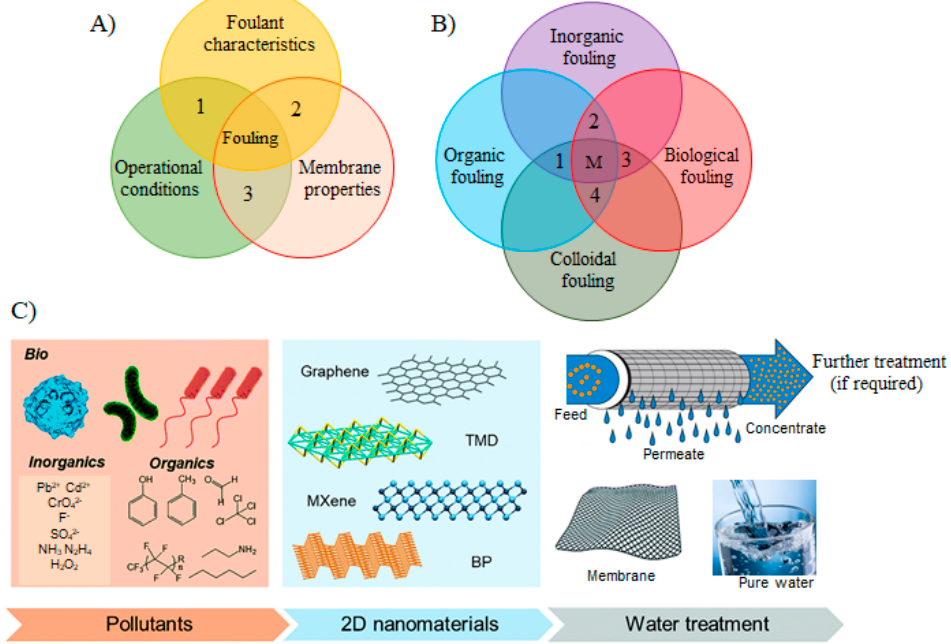
Figure 2. ( A ) Factors affecting the membrane fouling: (1) foulant characteristics such as concentration, size, solubility, diffusivity, hydrophobicity, charge, etc.; (2) membrane properties such as hydrophobicity, surface roughness, pore size, charge on membranes surface, and surface functional groups; (3) operational conditions such as flux, medium tempera- ture, and flow velocity, medium chemistry, pH, ionic strength, and presence of organic/inorganic matters (reproduced from [31] with permission from the Elsevier. ( B ) A schematic graphic of the various fouling mechanisms corresponding to the fouling materials. In the real membrane processes, fouling occurs as mixed fouling, i.e., the combination of different fouling mechanisms happening concurrently. The dotted lines in the diagram with areas 1, 2, 3, 4 and M show the different examples of mixed fouling between two or more fouling mechanisms. ( C ) A schematic illustration of the water/wastewater treatment processes utilizing the versatile behavior of 2DNMs in efficient membrane separation (reproduced from [39] with permission from the Royal Society of Chemistry). 3. Synthesis of 2DNMs Membranes The diverse properties of 2DNMs offer vast opportunities for the development of 2DNMs-based membranes that can possess a large density of nanochannels spread across the material grain, high flux, exceptional salt rejection, and persistent antifouling capabil- ity [40,41]. The ultrathin nanosheets with integrated structures are necessary for manufac- turing excellent performing 2DNM membranes. Generally, a top-down approach, which involves exfoliating the bulk layered crystals, and bottom-up approach, which involves direct production from the prime building units, are utilized to manufacture ultrathin 2DNM nanosheets [41]. Subsequently, the 2DNM nanosheets can be fabricated into con- tinuous separation layers by using different approaches such as filtration, spin coating, hot dropping, etc. Given nanosheets are usually either porous or nonporous, resultant membranes are classified into two types: a porous nanosheet membrane and a laminar membrane (Figure 3A). While porous nanosheet membranes are comprised of single or a few layers of 2D materials with built-in or drilled in-plane nanopores that allows perme- ation of molecules or ions selectively, the laminar membranes are manufactured by com- piling nanosheets into laminates having interlayer channels for the transport of molecules. Selection of materials such as the membrane base material, additives, solvent, and 2DNMs depends on the intended application of the membranes. Several approaches have been